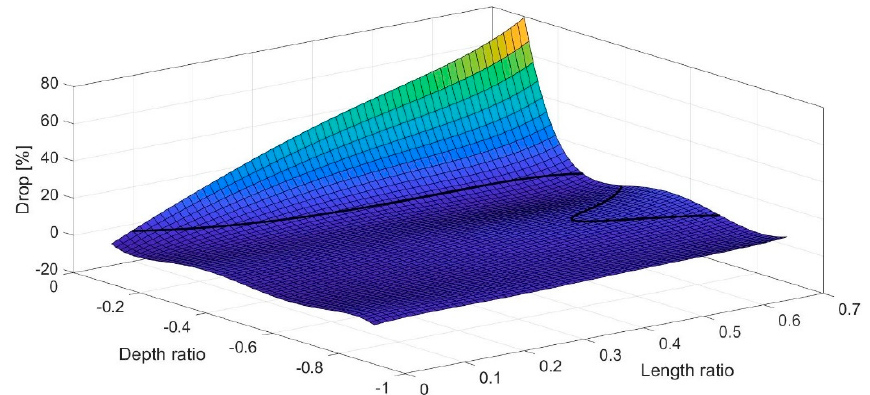
Figure 7. Intersection curve for drop = 6.2%.